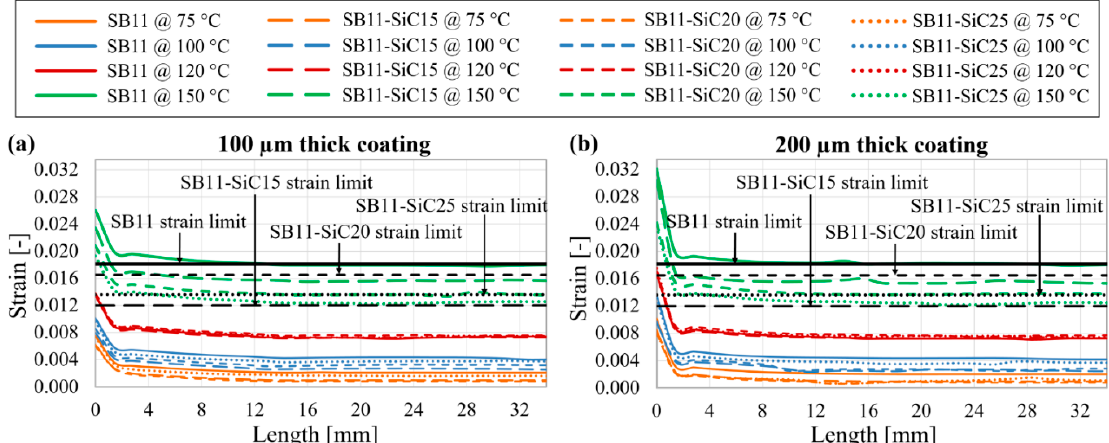
Figure 10. Equivalent strain of longitudinal path along the composite layer of tape: ( a ) model with 100 µm and ( b ) 200 µm thick composite coating, different SiC content and various quenching temperatures. For better clarity, only a half of the tape length is plotted; the strain distribution in the second half of the tape is approximately the mirror image of the opposite.